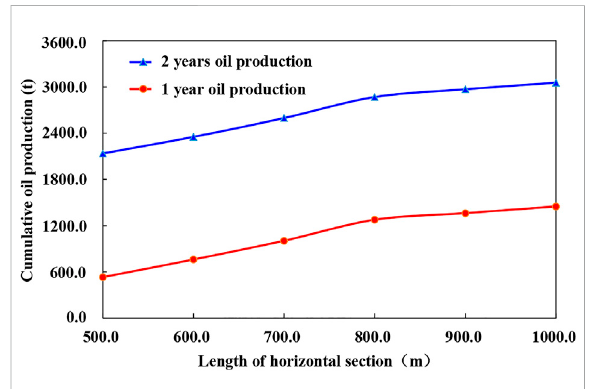
FIGURE 11 Cumulativeoilproductionofdifferentbowhorizontalsection lengths in 1 and 2 years.